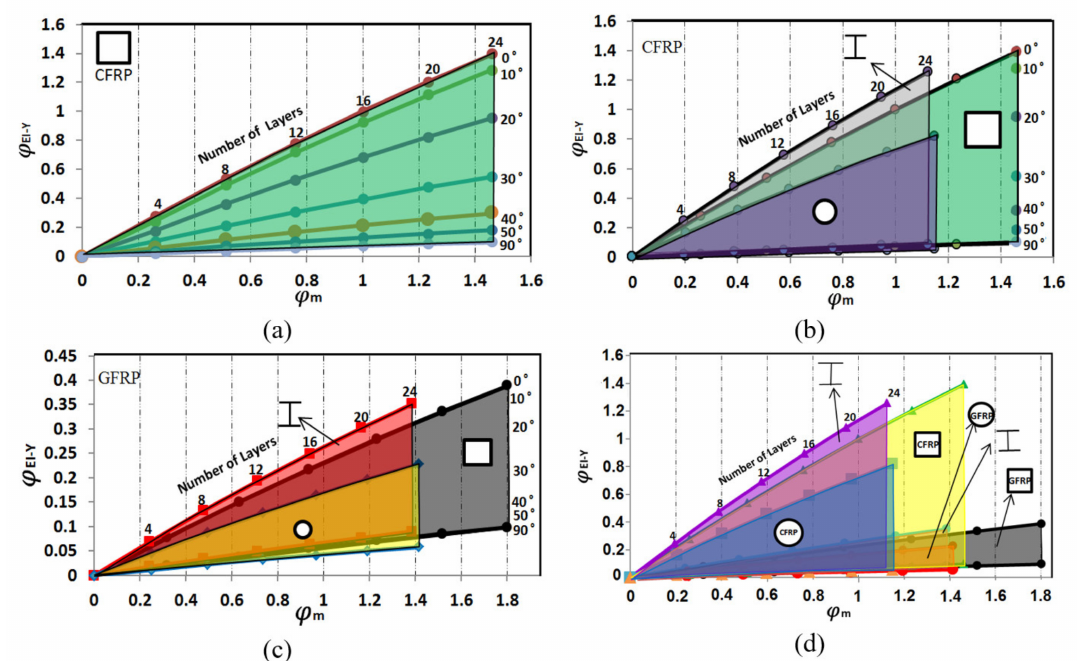
Figure 4. Normalized bending performance index: ( a ) square CFRP cross section, ( b ) performance comparison for different cross-sectional shapes using CFRP materials, ( c ) performance comparison for different cross-sectional shapes using GFRP materials, and ( d ) performance comparison for various cross-sections constructed from CFRP and GFRP